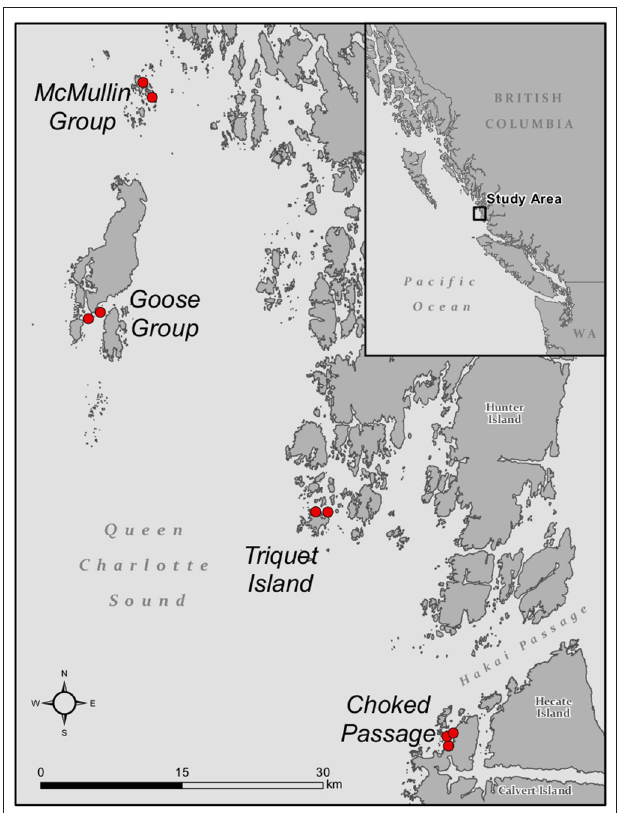
FIGURE 1 | Map showing the sampled seagrass meadows across four regions along the Central Coast of BC. A total of 54 Zostera marina shoots and 35 seawater samples were